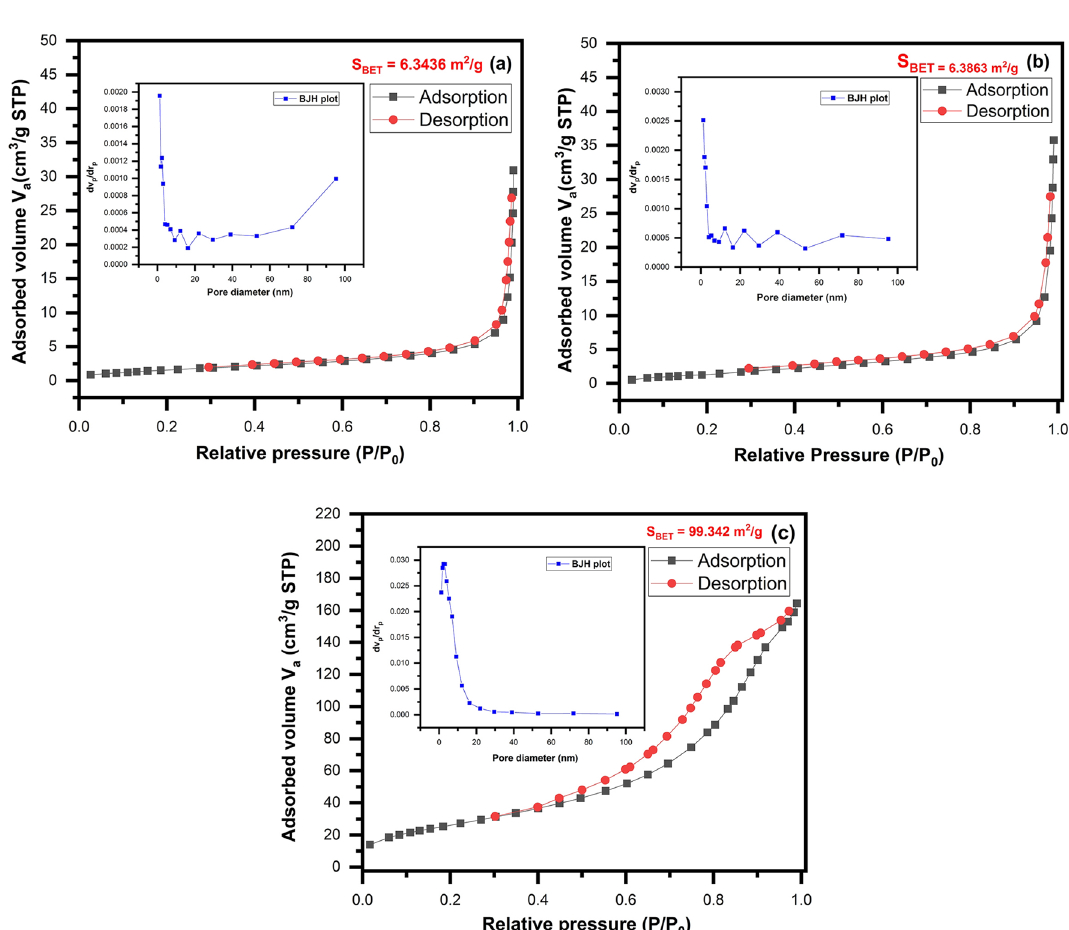
Figure 7. Nitrogen adsorption–desorption isotherms of ( a ) ZnO, ( b ) ZnO/Chitosan and ( c ) MWCNTs/ZnO/ Chitosan, Inset: pore size distribution of the prepared samples from the adsorption isotherm measurement.